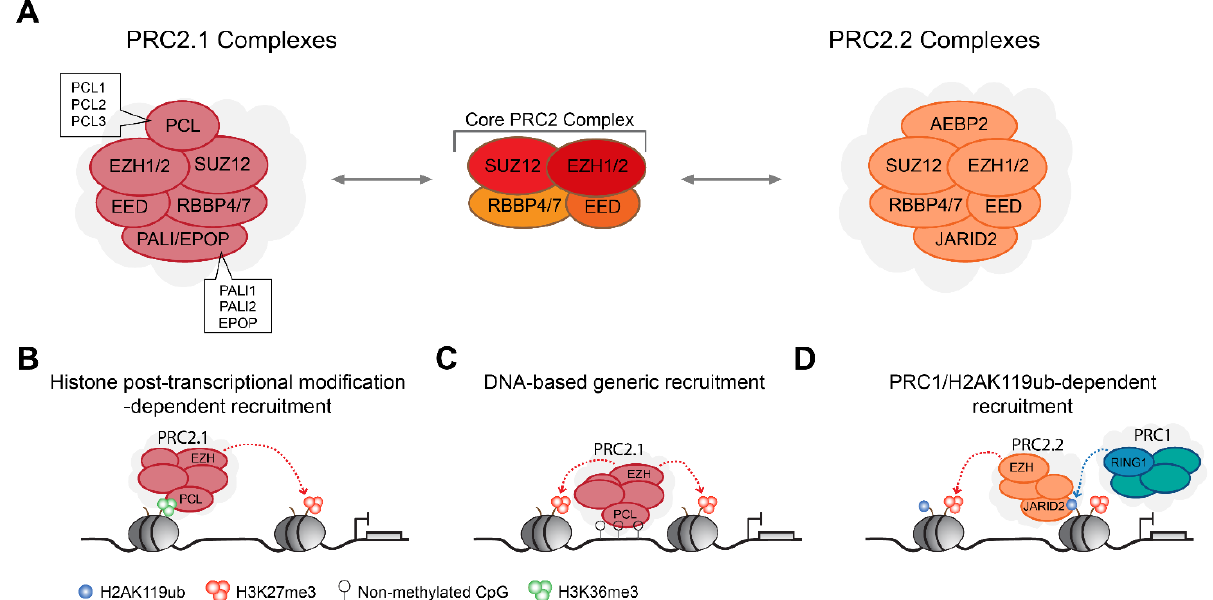
Figure 2. Composition of PRC2-type complexes. ( A ) PRC2 complexes are divided into two main groups, PRC2.1 and PRC2.2. Both groups contain at their core RBBP4 or RBBP7, EED, SUZ12, and a histone methyltransferase subunit EZH1 or EZH2 that catalyzes H3K27me3. The PRC2.1 complex contains a PALI or an EPOP subunit, and a PCL protein that recognize the H3K36me2/3 histone marks. The PRC2.2 complex contains AEBP2 protein and a JARID2 protein that recognize PRC1-mediated H2AK119ub. ( B – D ) Illustration of three major mechanisms for PRC2 recruitment. ( B ) Histone modifications can mediate PRC2.1 recruitment via H3K36me3 reader activity of PCL proteins. ( C ) Similar to PRC1, PRC2.1 complexes also display a DNA-based generic recruitment via PCL proteins winged-helix domain binding activity to genomic regions enriched for CpG islands. ( D ) PRC2 recruitment can also be mediated in a PRC1-dependent manner, through H2AK119ub reader activity of the core PRC2.2 subunit JARID2.